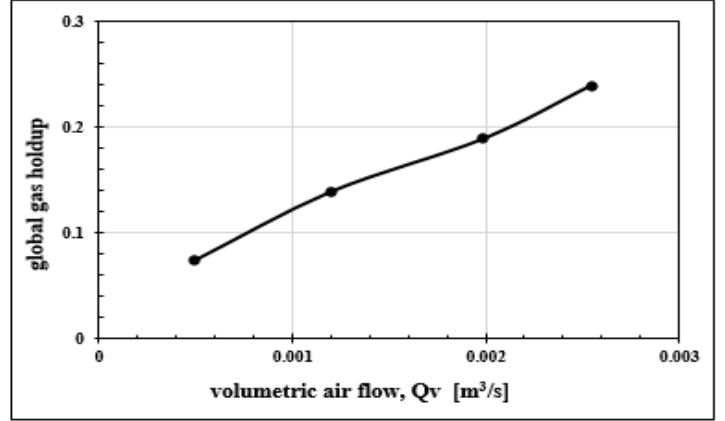
Figure 12. Relationship between global gas holdup and volumetric air